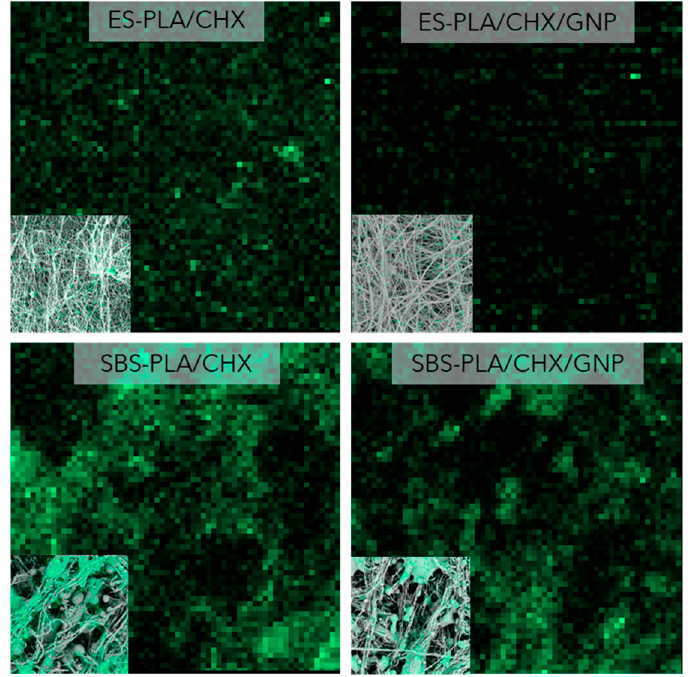
Figure 7. SEM-EDS analysis of nanofibers membranes obtained by electrospinning or solution blow spinning of ES-PLA/CHX, SBS-PLA/CHX, ES-PLA/CHX/GNP, SBS-PLA/CHX/GNP.